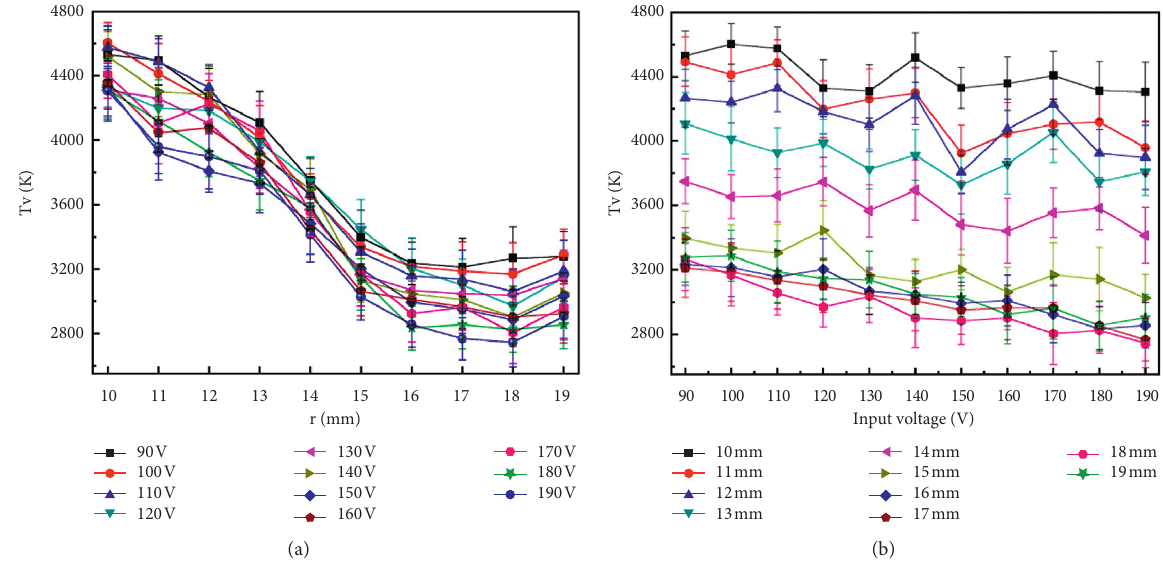
Figure 12: (a) Vibrational temperature varied with the radius of the coaxial DBD-PACA at different input voltage; (b) vibrational temperature varied with the input voltage at different points.